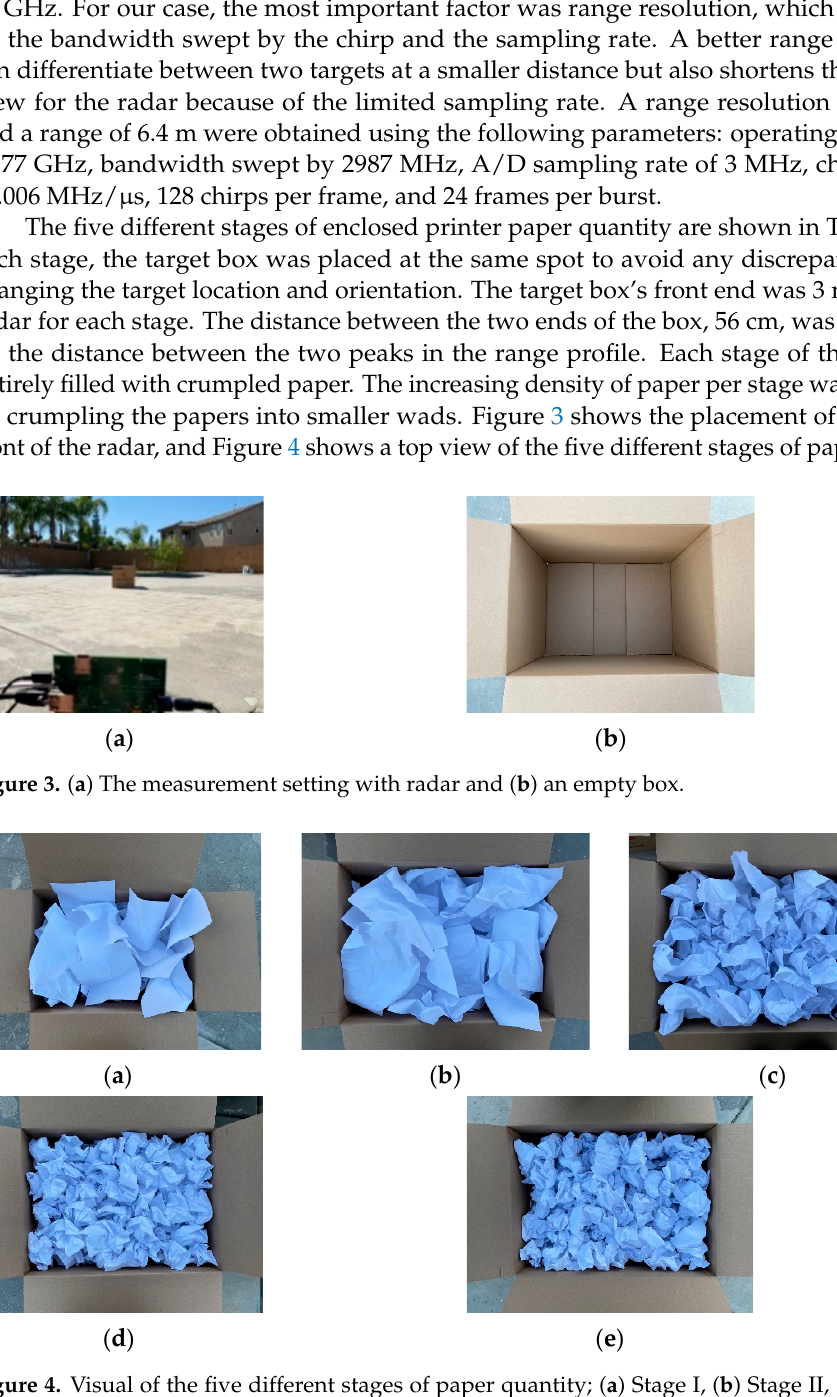
( f ) Figure 5. Range-profiles for ( a ) an empty box, ( b ) stage 1, ( c ) stage 2, ( d ) stage 3, ( e ) stage 4, and ( f ) stage 5. The empty stage, presented in Figure 5a, shows both reflection magnitudes roughly equal to each other because the attenuation of the electromagnetic wave inside the box is negligible. The only effect of power dissipation occurs from the two thin layers of the cardboard box, which introduce complex permittivity. Each of the following five stages shows power dissipation with increased paper quantity. Stage V was packed with the highest amount of paper for almost 100% power dissipation, with the second peak absent. Table 2 shows the attenuation ratio between the two peaks for every stage. It is noted that adding permittivity in between shifts the second peak due to the different propagation time delay. However, the amount is so small that we could not observe it in our experi- ments. The results obtained for measurements and calculations were close for most stages. Differences in attenuation might result from the general makeup of the material, including